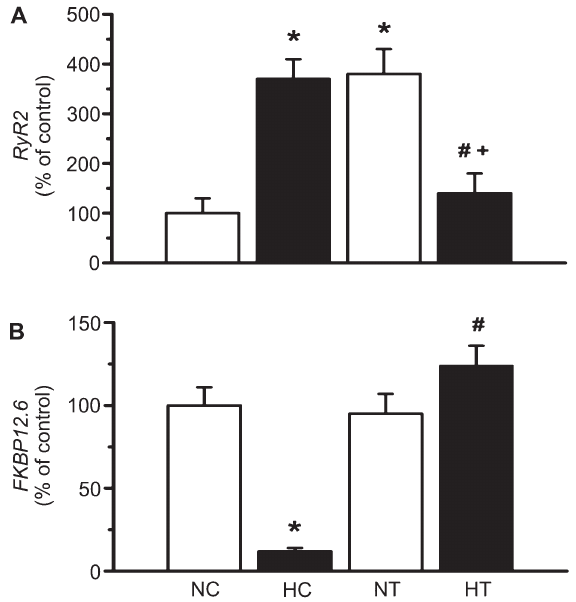
Figure 1. Gene expression of ( A ) RyR2 and ( B ) FKBP12.6 in left ventricles. NC: normotensive control; HC: hypertensive control; NT: normotensive trained; HT: hypertensive trained. Data are reported as means±SE of 5-6 animals in each group. *P , 0.05, compared to NC; # P , 0.05, compared to HC; + P , 0.05, compared to NT (two-way ANOVA followed by the post hoc Tukey